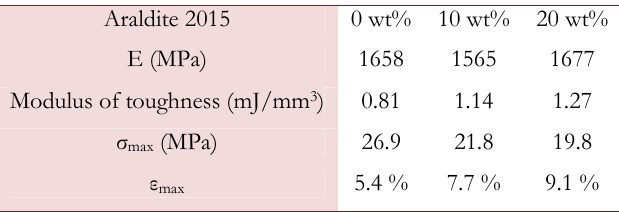
Table 4: Results from the tensile tests on adhesive